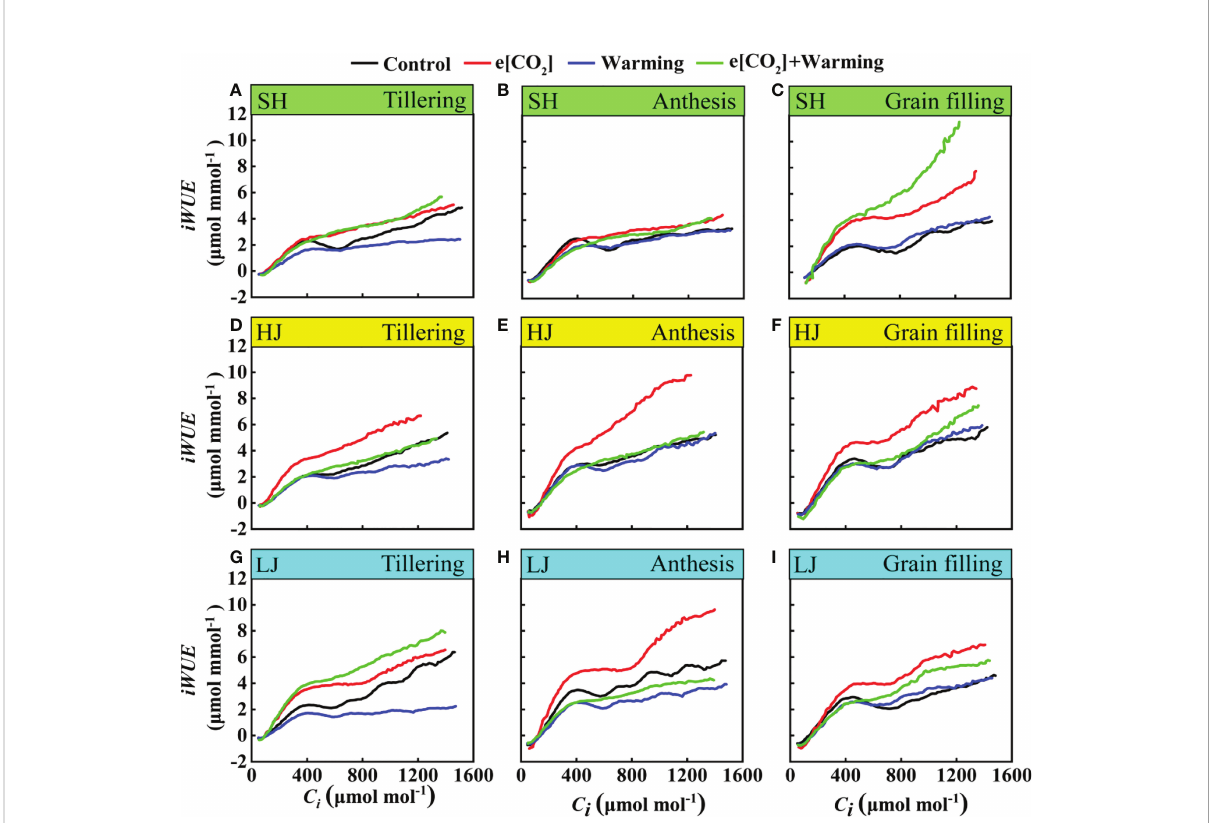
FIGURE 9 The iWUE - C i Curves under ambient [CO 2 ] and temperature (black dots, Control), elevated [CO 2 ] (red dots, e[CO 2 ]), elevated temperature (blue dots, warming), and e[CO 2 ] plus warming (green dot, e[CO 2 ]+warming) for cv. SH ( A-C ), HJ ( D-F ), and LJ ( G-I ) during the stage of tillering anthesis, and grain- fi lling. iWUE represents instantaneous water use ef fi ciency, C i represents intercellular carbon dioxide